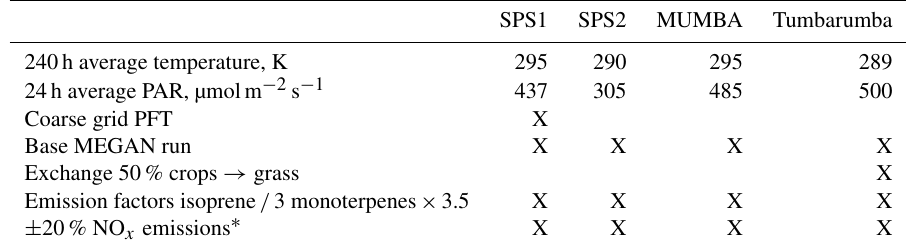
SPS1 SPS2 MUMBA Tumbarumba